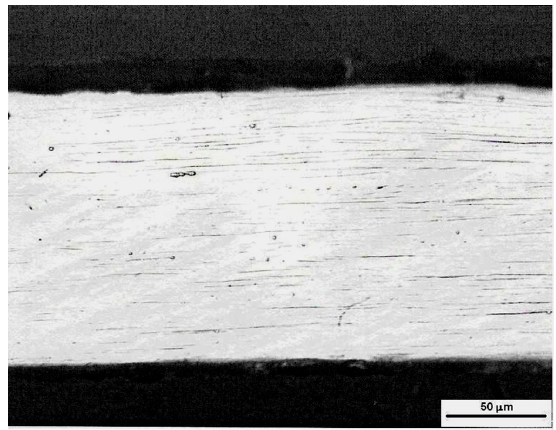
Figure 5. The tube EW longitudinal section. Metals 2019 , 9 , x FOR PEER REVIEW